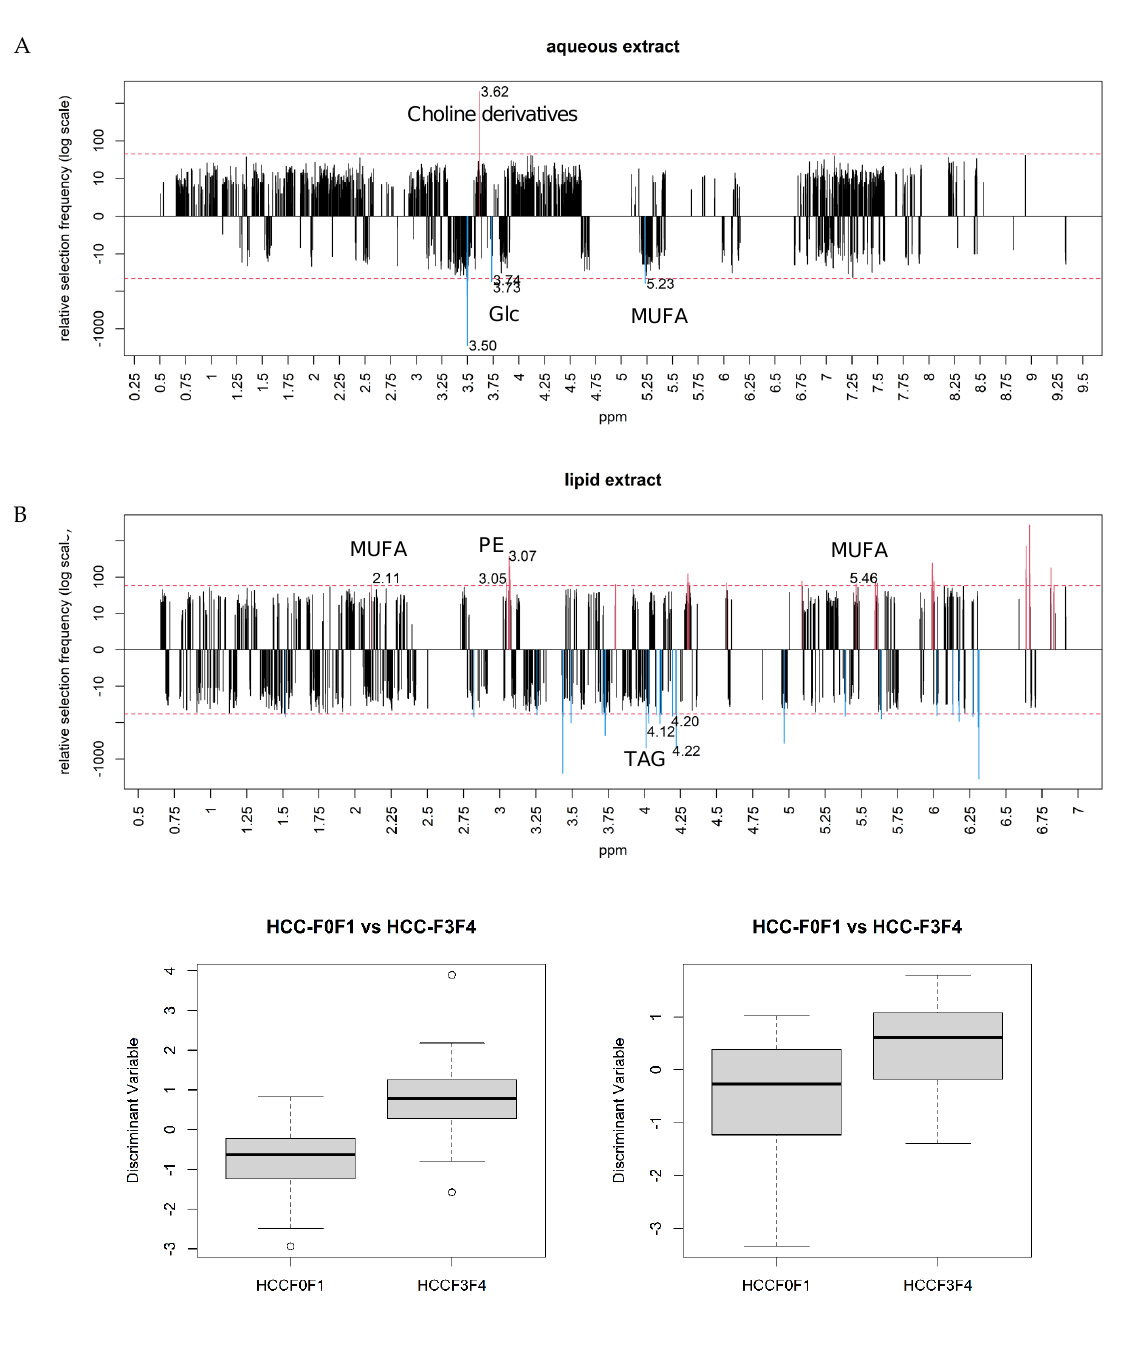
Figure 3. Frequency of selection of each ppm location in the aqueous ( A ) and lipid phases ( B ) from the comparison between HCC-F0F1 and HCC-F3F4. Discriminant metabolites (above the number of selection threshold in dotted line) are illustrated in red for upregulated and blue for downregulated metabolites in HCC-F0F1. In the aqueous phase ( A ), choline derivatives (ppm 3.62), glucose (ppm 3.50/3.73–3.74), and monounsaturated FA (ppm 5.23) were identified as discriminant metabolites. In the lipid phase ( B ), monounsaturated fatty acids (ppm 2.11/5.46), phosphoethanolamine (ppm 3.05–3.07), and triacylglycerides (ppm 4.12/4.22) were identified as discriminant metabolites. Subsets of metabolites in the aqueous ( C ) and lipid phases ( D ) demonstrated significant accuracy to differentiate HCC from NTT in F0F1 fibrosis.